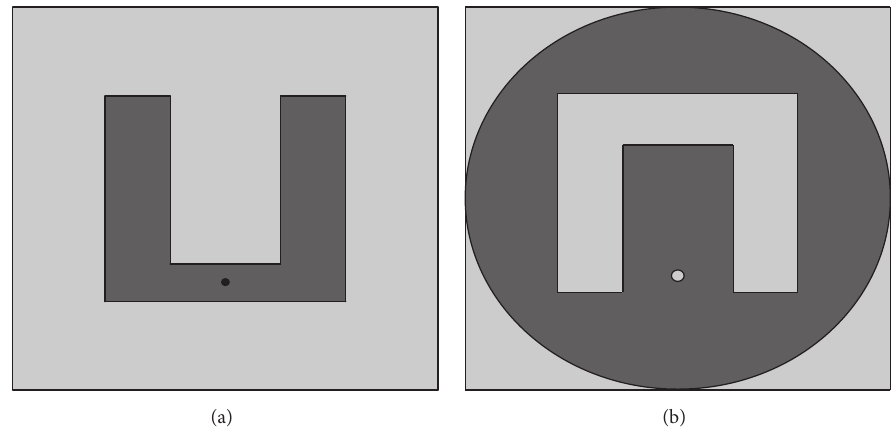
Figure 3: U-shaped patch antenna with a U-slot embedded in a circular/square ground plane [12]. Top view (a) and bottom view (b). The black dot point indicates the pin of the coaxial probe. Dark gray monopole and light gray dielectric